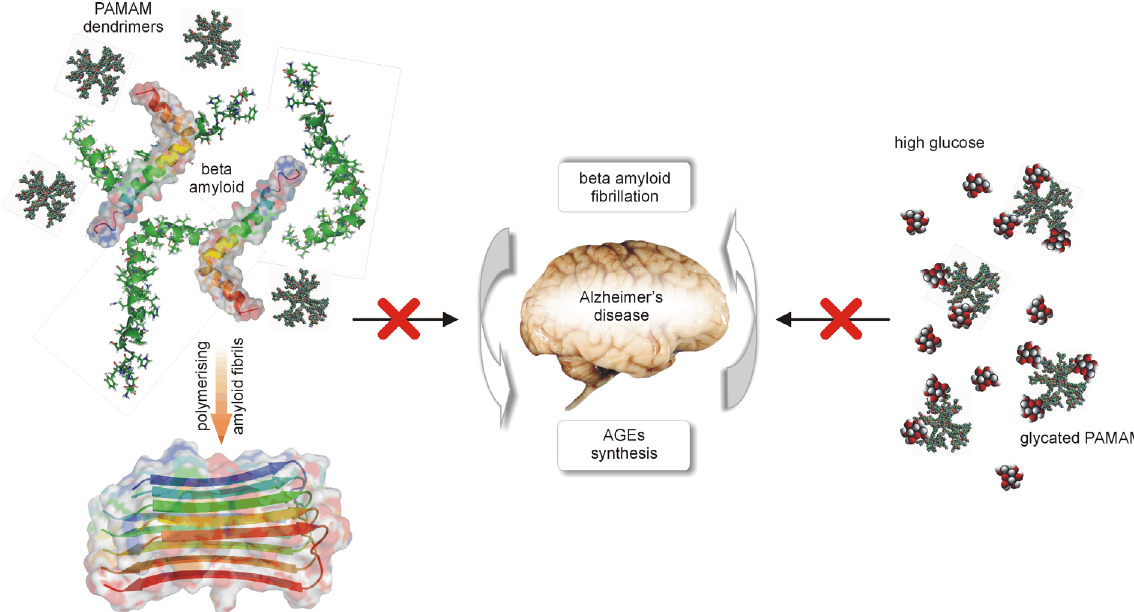
Figure 13. PAMAM dendrimers disrupt the association between the formation of advanced glycation end-products (AGEs) and β -amyloid fibrils. In parallel with reduced formation of fibrils of β -amyloid, diminished AGE synthesis occurs in the brain affected by Alzheimer’s disease. In addition, PAMAM-mediated scavenging of excess glucose in the peripheral nervous system decreases the vulnerability of neurons to